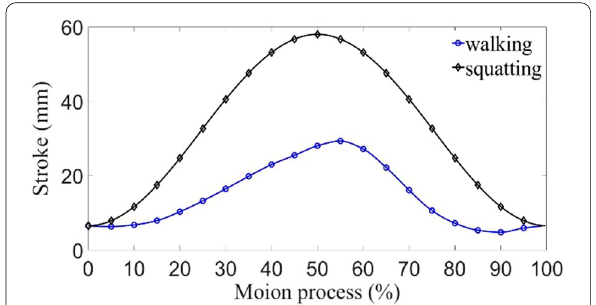
Figure 8 Stroke range in walking and squatting cycles